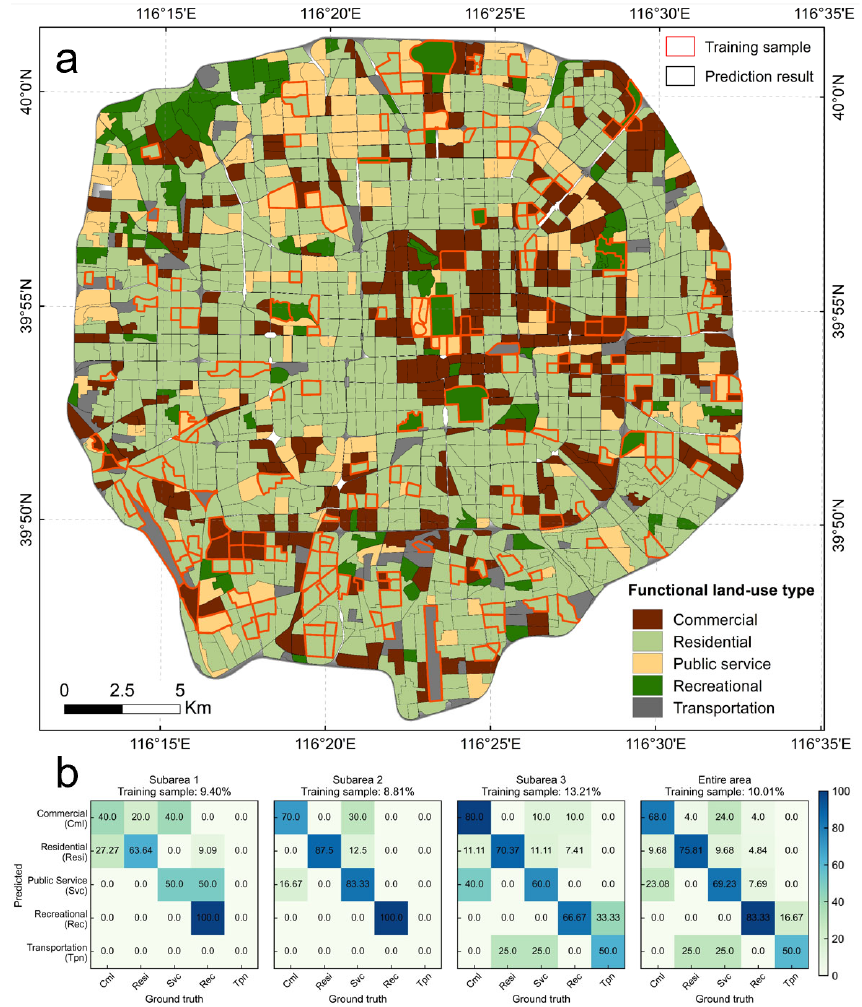
Figure 8. ( a ) Functional area prediction result within the 5th ring road of Beijing; ( b ) confusion matrixes of the 3 sub-regions, respectively. The row-normalized matrixes where diagonal element are user accuracies of the corresponding functional land use types.